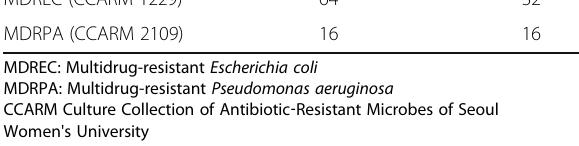
SAMP-5 and melittin against multidrug-resistant Gram-negative bacteria Strains SAMP-5